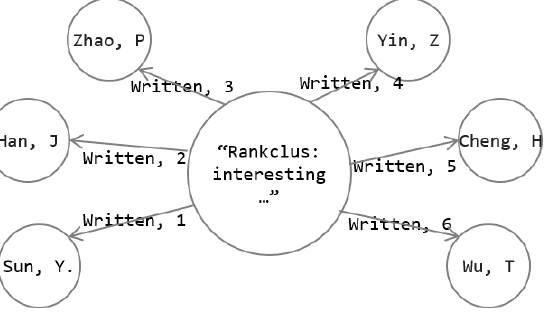
Figure 4. Example of BIN {Paper-Author}.